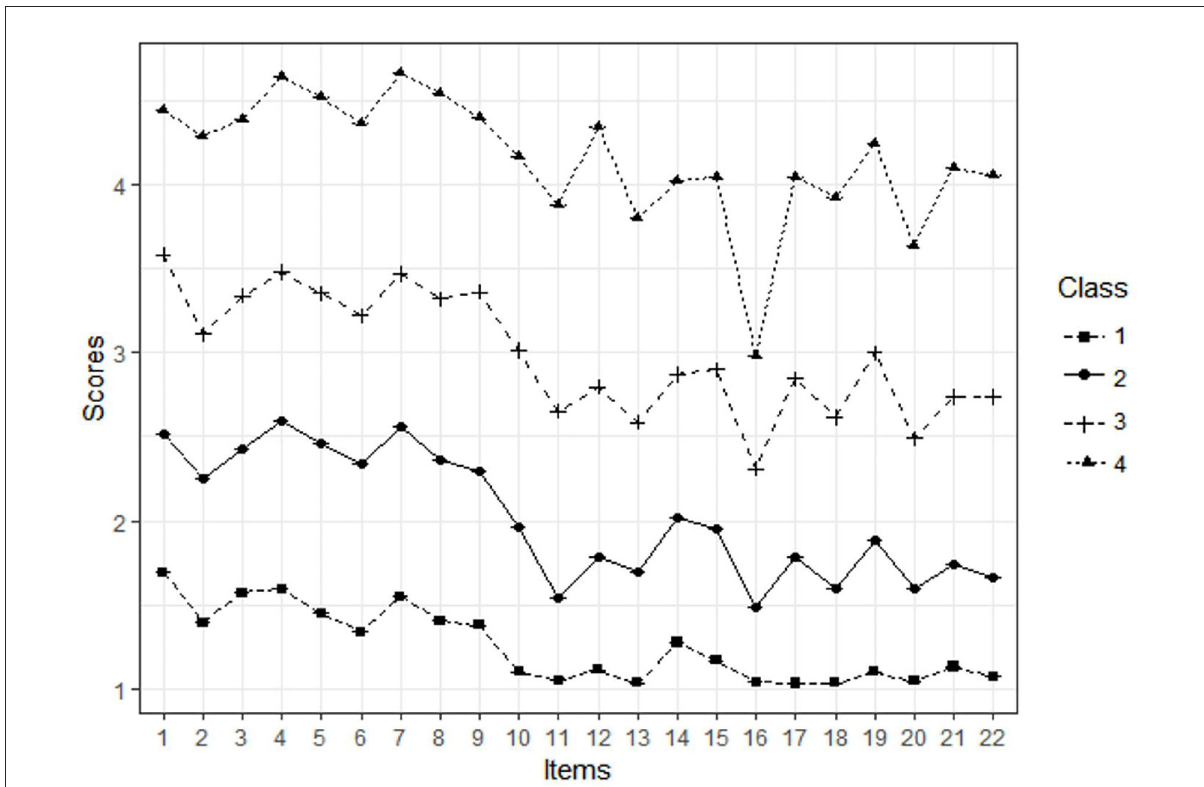
FIGURE1 The distribution of four potential classes of stress